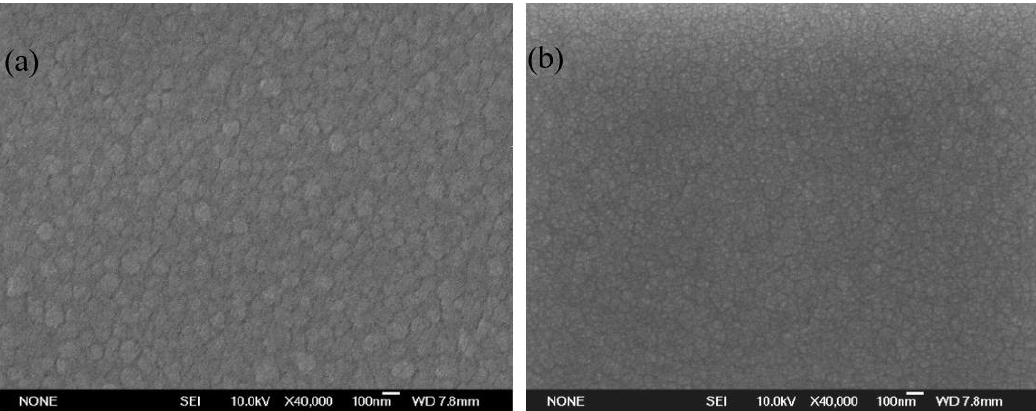
Figure 7. Surface SEM images of TiMoAlON film ( a ) before and ( b ) after baking. The cross-sectional SEM image of the Ti/(Mo-TiAlN)/(Mo-TiAlON)/Al 2 O 3 tandem ab-